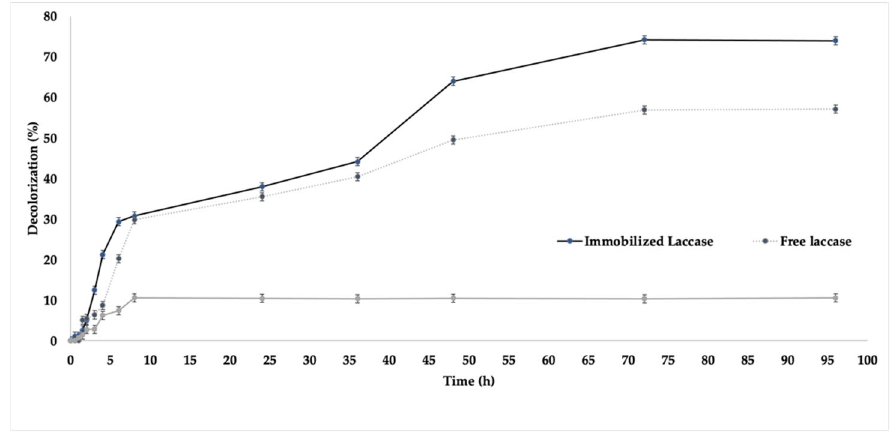
Figure 7. Investigation of decolorization of RBBR catalyzed by free and immobilized L Asp